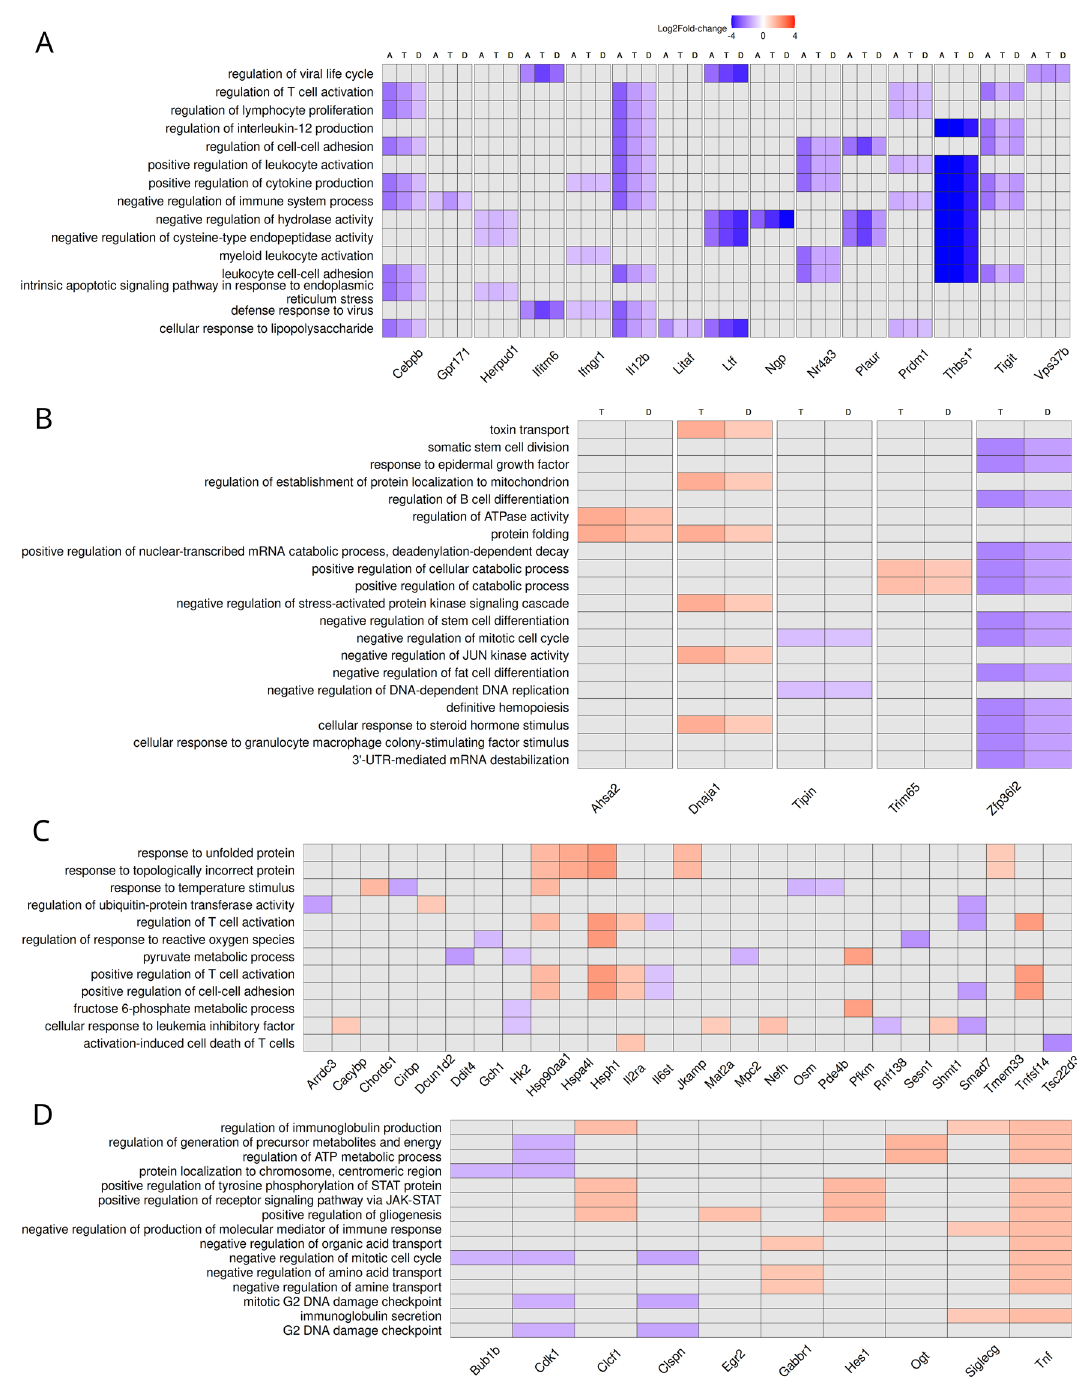
Figure 5. Venn Regions enriched Biological Processes Gene Ontology terms – DEGs heatmap. Heatmaps (Log2FC): ( A ) Common DEGs (A: Antigen-only, T: Tolerant/2 nM, D: Desensitized/5 nM), ( B ) Common DEGs for SLIT receiving groups (T: Tolerant/2 nM, D: Desensitized/5 nM), ( C ) Tolerant/2 nM exclusive DEGs, ( D ) Desensitized/5 nM exclusive DEGs. * DEGs with absolute Log2FC >